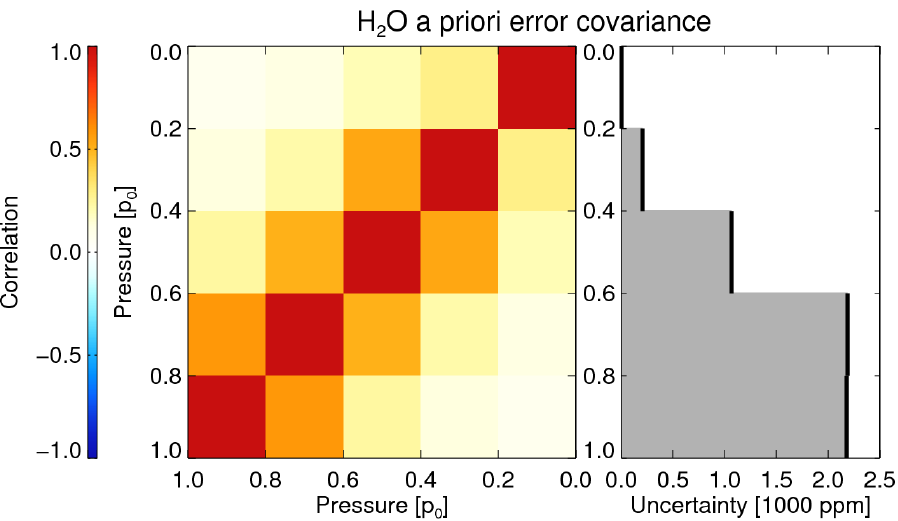
Figure 5. As Figure4 but for H 2 O and estimated from day-to-day variations of ECMWF analysis profiles (without variance scaling as done for CO 2